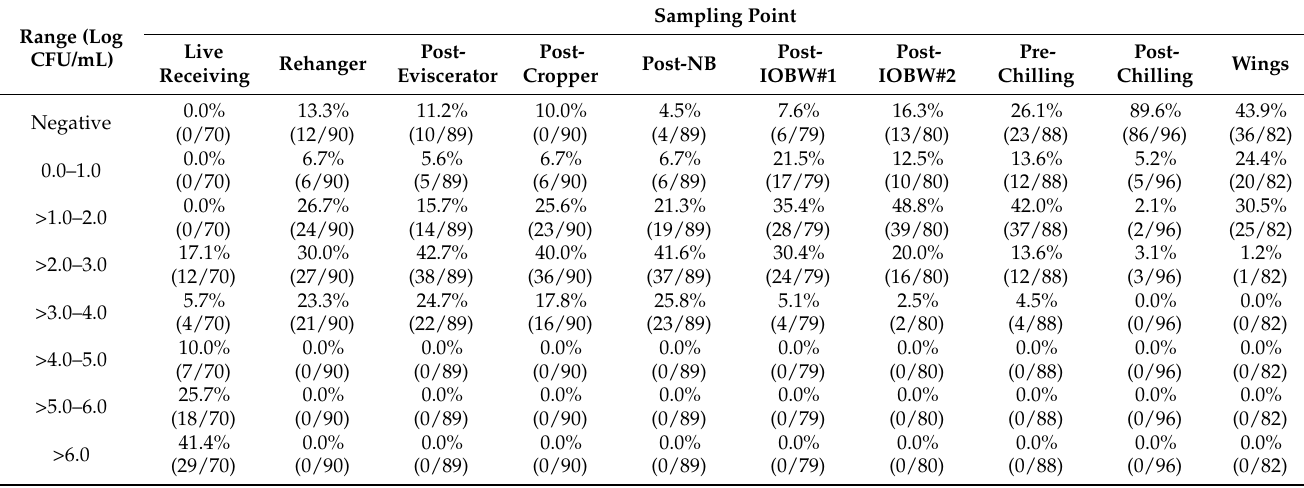
Table A8. Distribution of Campylobacter counts (Log CFU/mL) on each of the ten sampling locations under reduced process intervention on chicken and part rinses (n = 853